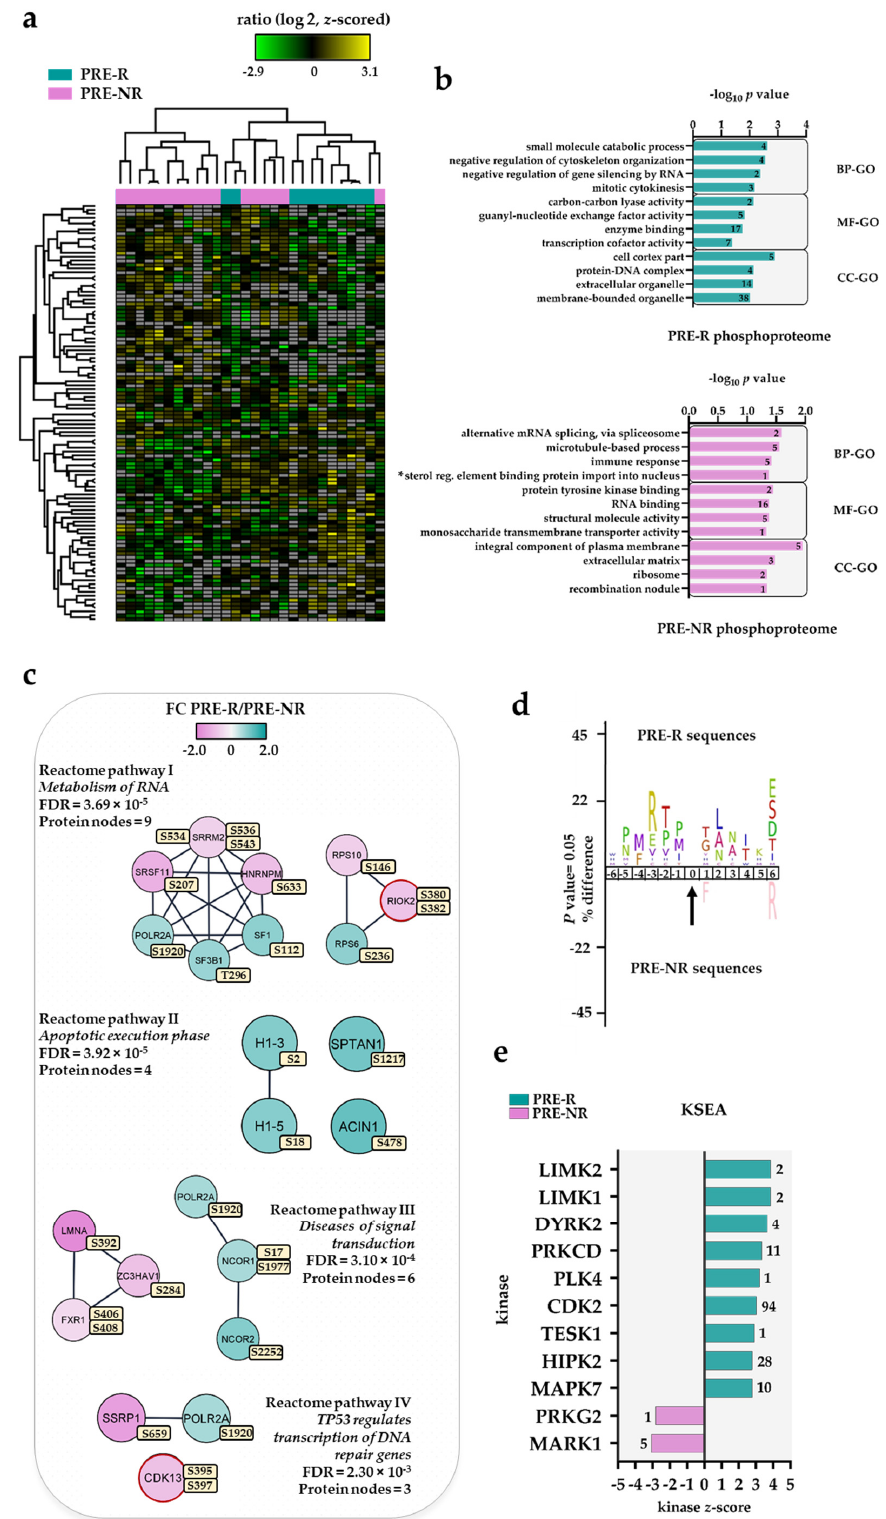
Figure 3. The pre-treatment AML cell phosphoproteome is enriched in RNA metabolism and apoptosis phosphoproteins, as well as cyclin dependent kinase (CDK) targets for PRE-R patients: ( a ) hierarchical clustering of 107 differentially